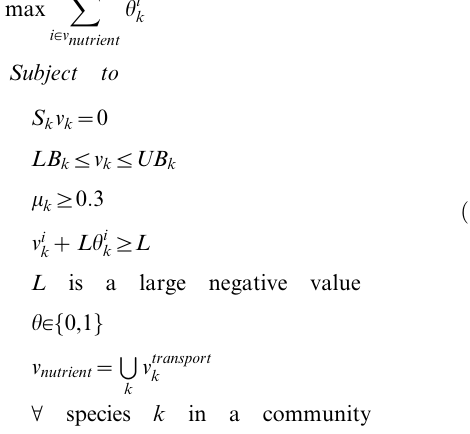
Figure S4 Emergent metabolites detected when the entire growth period was considered. As in Figure 4, rows represent emergent metabolites (ranked by prevalence) and columns represent specific community/medium combinations. Emergent secretion events detected at 1 hr ( i.e. those that are included also in Figure 4) are illustrated as black bars. Emergent secretion events (and emergent metabolites) that were detected only when the entire growth period was considered but not in the early growth period are labeled in blue. Figure S5 Overall consistency in emergent biosynthetic capacity detected in early and late growth. ( A ) The average number